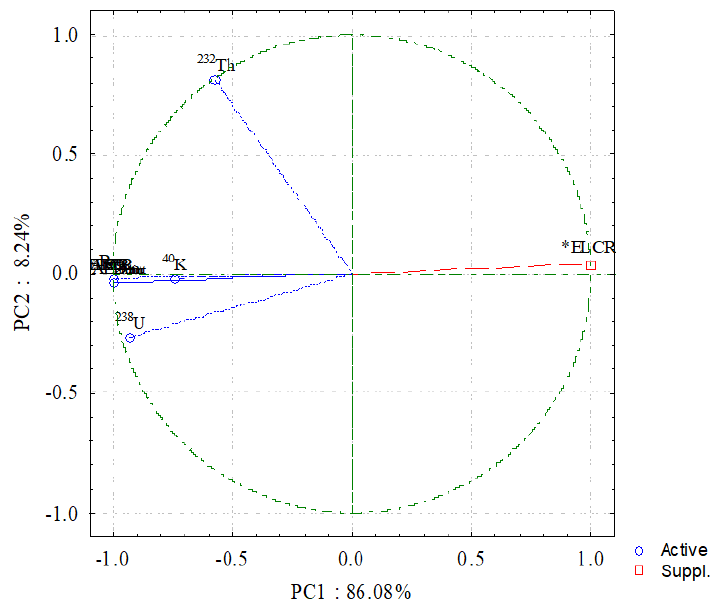
Figure 11. Graphical representation of PC1 and PC2; * is supplementary variable.